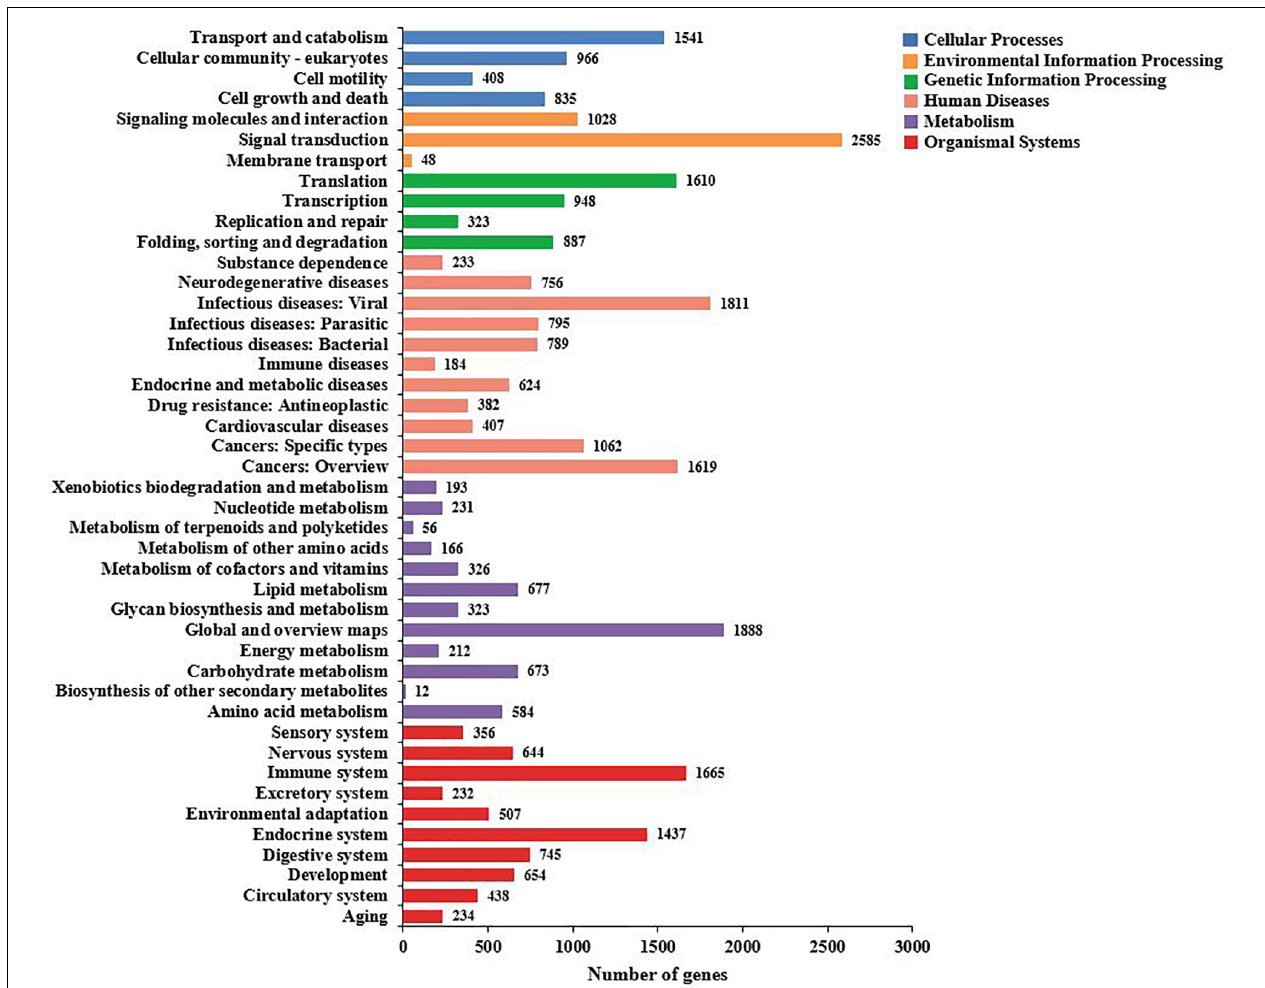
FIGURE 6 | The Kyoto Encyclopedia of Genes and Genomes (KEGG) biological pathway classification histograms for annotated unigenes identified in the hemocytes of Marsupenaeus japonicus . Each bar represents the number of unigenes classified into different biological processes. The X -axis shows the number of matched unigenes, while the Y -axis shows the pathways from the KEGG